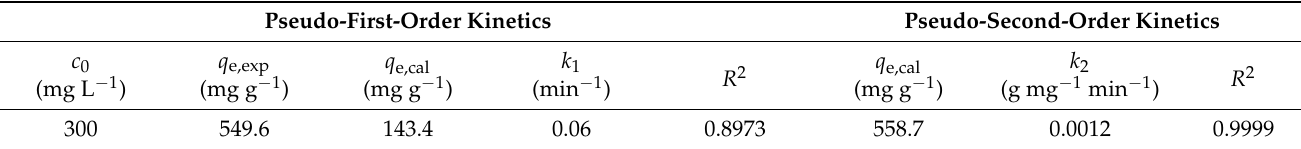
Table 1. Pseudo-first order and pseudo-second order kinetics parameters. Pseudo-First-Order Kinetics